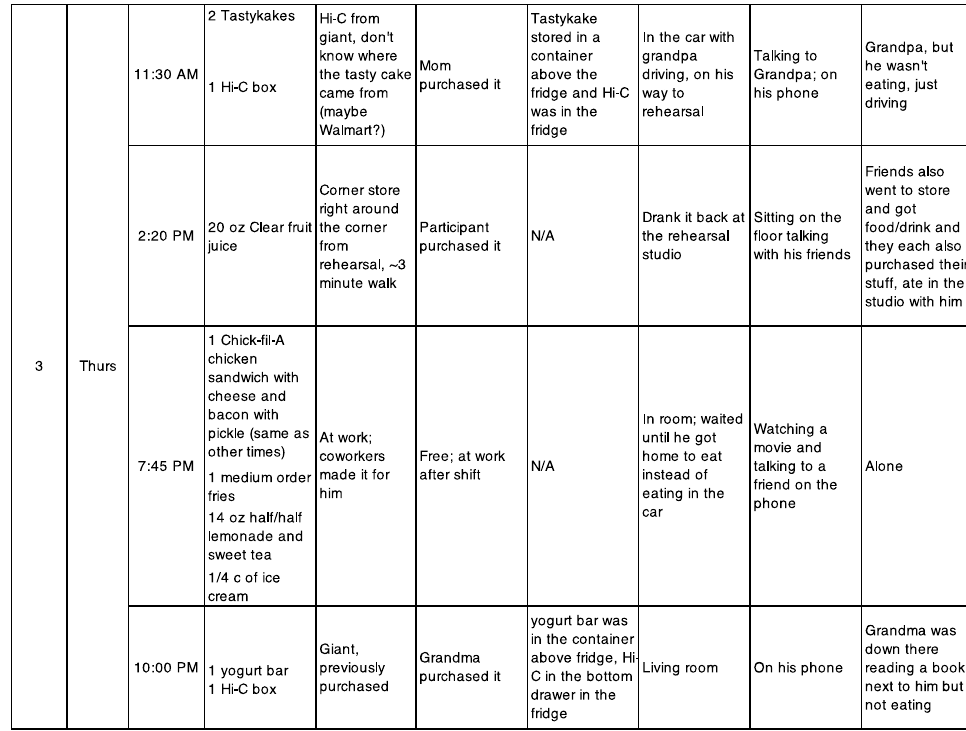
Figure A1. Example of Food Log Spreadsheet for Participant A. Food logs were collected concurrently with the 24-h dietary recalls.